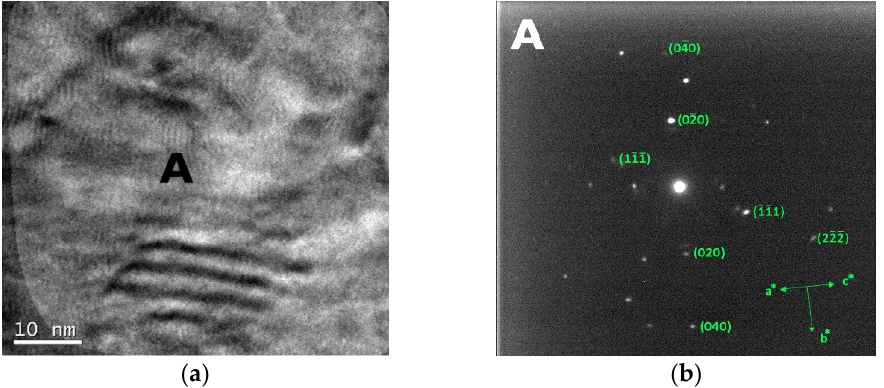
( a ) ( b ) Figure 10. Bright field TEM images ( a ) and the corresponding SAED pattern ( b ) of the inter-den- dritic phase in the CoCrFeMnNiZr alloy after recrystallization. Available literature data indicate that only a single FCC phase exists in the CoCrFeMnNi HEA [60,61] so that all grains can be considered as belonging to the same phase. For the re-crystallized Zr-added alloy, the average grain size obtained from elec- tron microscopy is 5.2 µm, in agreement with the (6.0 ± 1.5) µm value determined by op- tical microscopy. 3.2. Mechanical Properties The micro-hardness of the as-cast, cold-worked and re-crystallized samples of the two HEAs compositions was measured in randomly selected locations including both dendritic and inter-dendritic phases, as described in Section 2. The results are visible in Figure 11. As reported in the optical micro-graphs of Figure 8, no cracks are visible for both compositions. No statistically significant difference in micro-hardness is observed between the cold- worked alloys. They both harden with the typical behaviour of FCC structures with low stacking fault. As expected, as a result of the usual solute effect on hardness, the smaller hardness values were observed in the CrCoFeMnNi Cantor’s alloy in the as-cast and re- crystallized state. Noteworthy, the cold-rolled base alloy exhibits a better work hardening capability compared to the Zr-modified one.